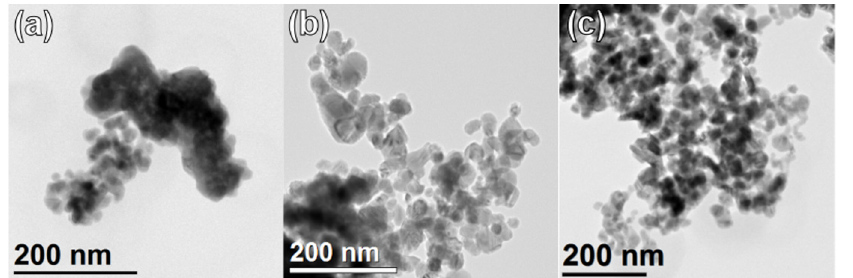
Figure 4. TEM images of regions of the Co(10)/Nd 2 O 3 ( a ), Co(31)/Nd 2 O 3 ( b ), Co(50)/Nd 2 O 3 ( c ) catalysts.